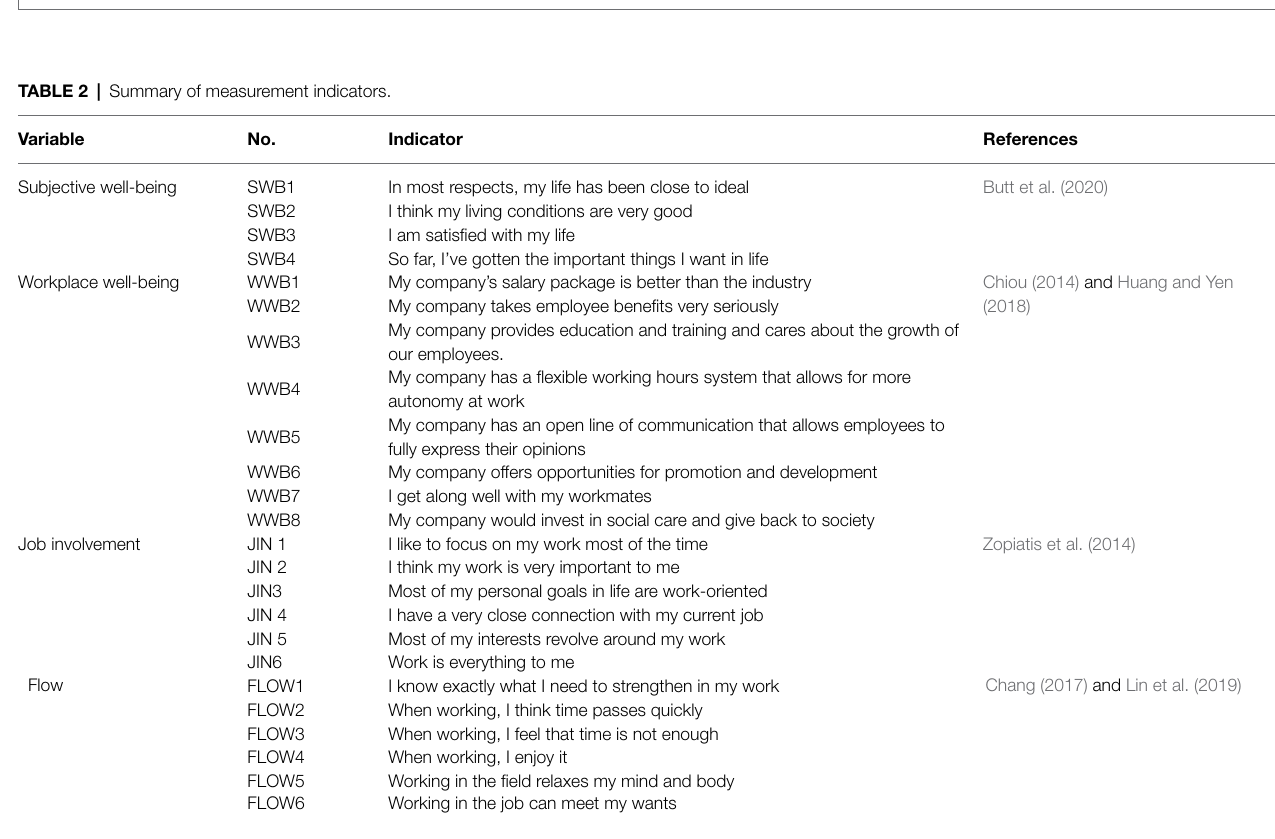
FIGURE 1 | Research